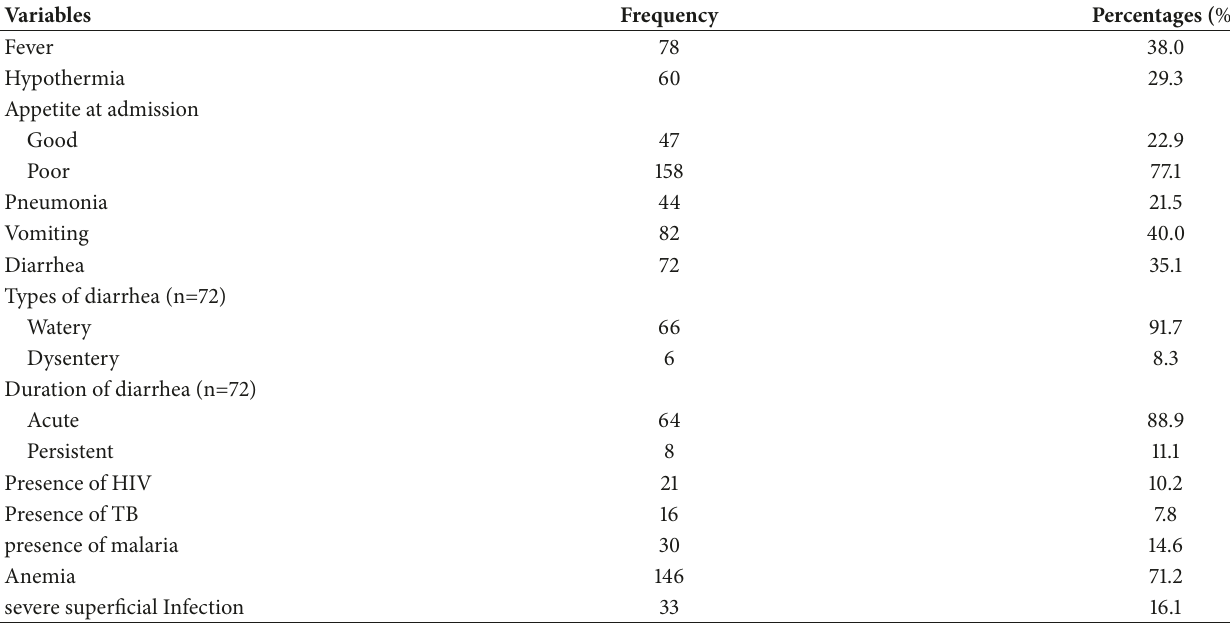
Table 2: Distribution of medical comorbidities information on treatment outcome of children with SAM admitted to Pediatric Ward of NRH, West Ethiopia, from November 2015 to April 2017 (n=205).